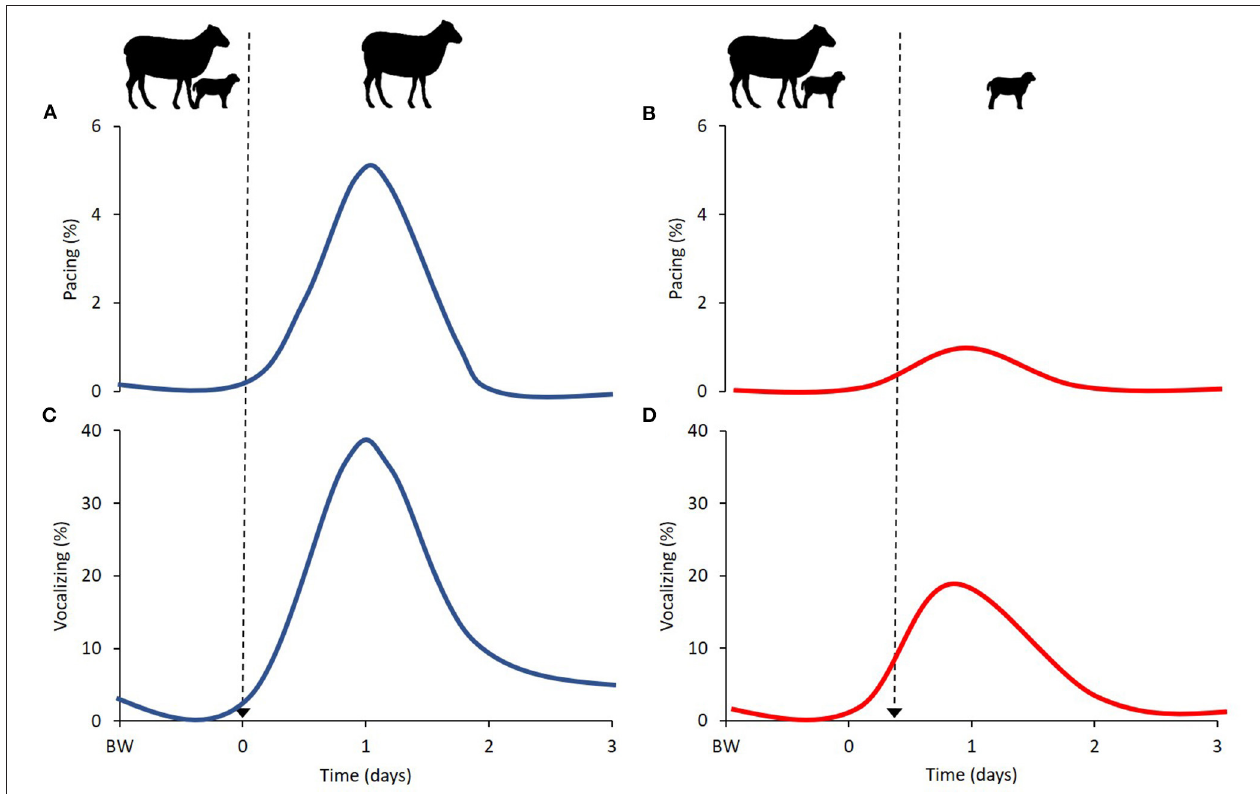
FIGURE 3 | Behavioural changes in ewes (left panel) and lambs (right panel) triggered by weaning (dotted arrow). The upper graphs show the time spent pacing (A,C) and the one below, the emission of vocalisations (B,D) . The models are based in the data of Freitas-de-Melo and Ungerfeld (2020).